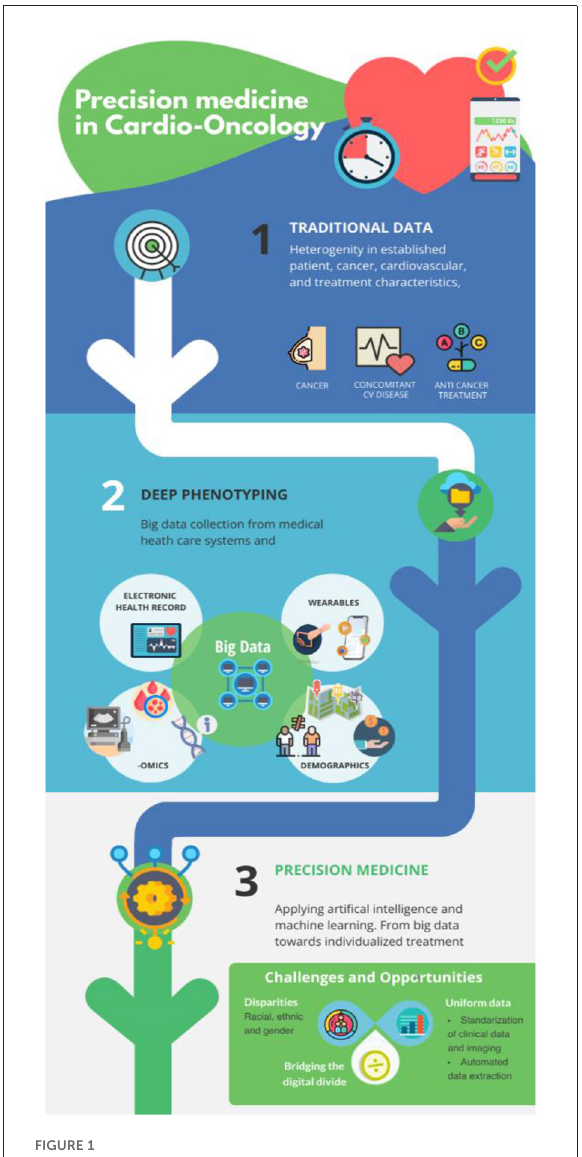
FIGURE1 From traditional approaches toward precision medicine in cardio-oncology: Implementation of non-routine collected data will generate additional valuable information. AI and machine learning are instrumental for meaningful deep phenotyping of the cardio-oncology patient and lead to more personalized and better CV